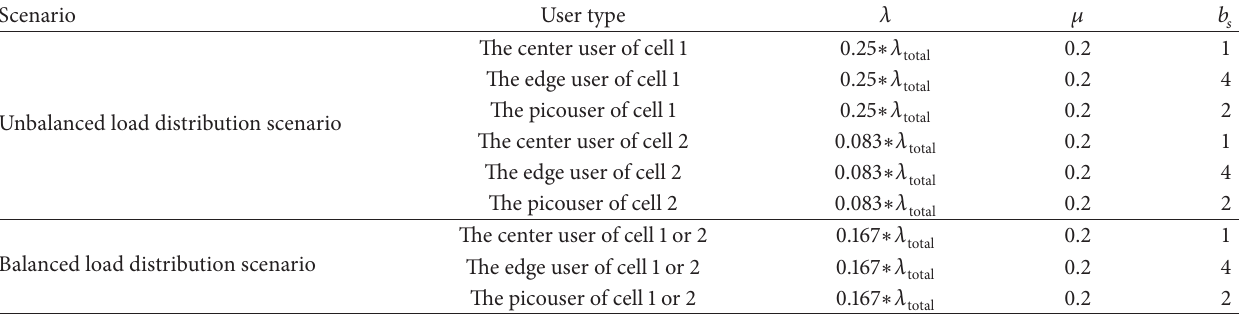
Table 1: The Markovian model